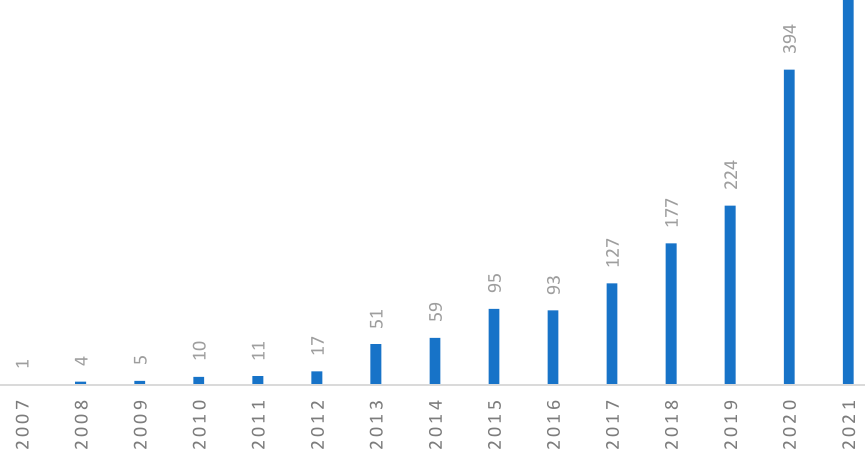
Figure 1. Number of documents per year related to Google Trends according to Scopus (analysis performed by the authors of this article in title-abstract-keywords fields, on 16 February 2022).